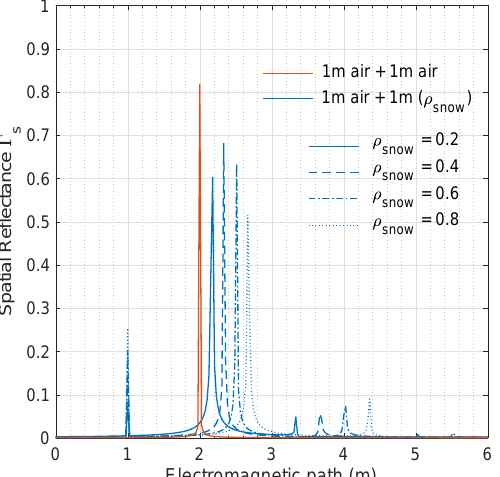
Figure 7. SFCW radar simulated spatial reflection of a 1 m snowpack with the relative densities 0, 0.2, 0.4, 0.6, and 0.8.